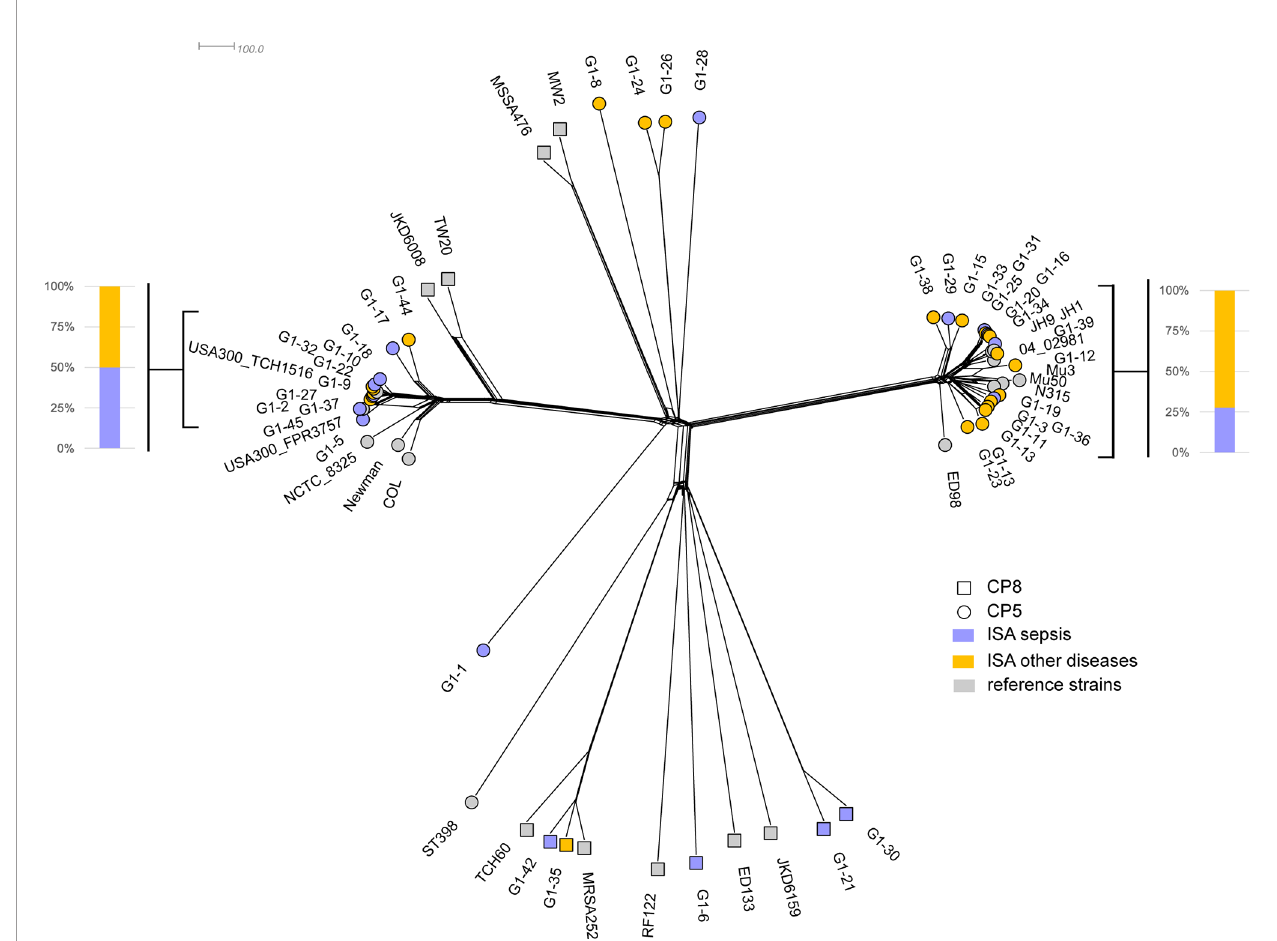
FIGURE 1 | The neighbor phylogeny based on the variability of MLST genes + 2208 species core genes. Violet and yellow tips indicated strains from patients in ISA group with sepsis and other primary diseases, respectively. Grey tips indicated the 22 reference